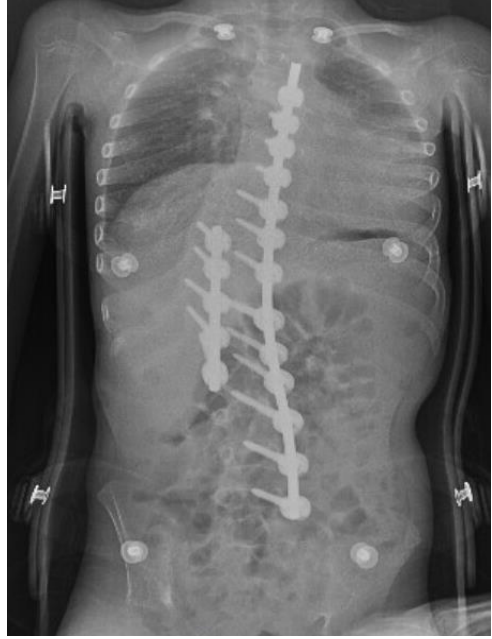
Figure 2. X-ray after surgery with instrumentation in the correct position.